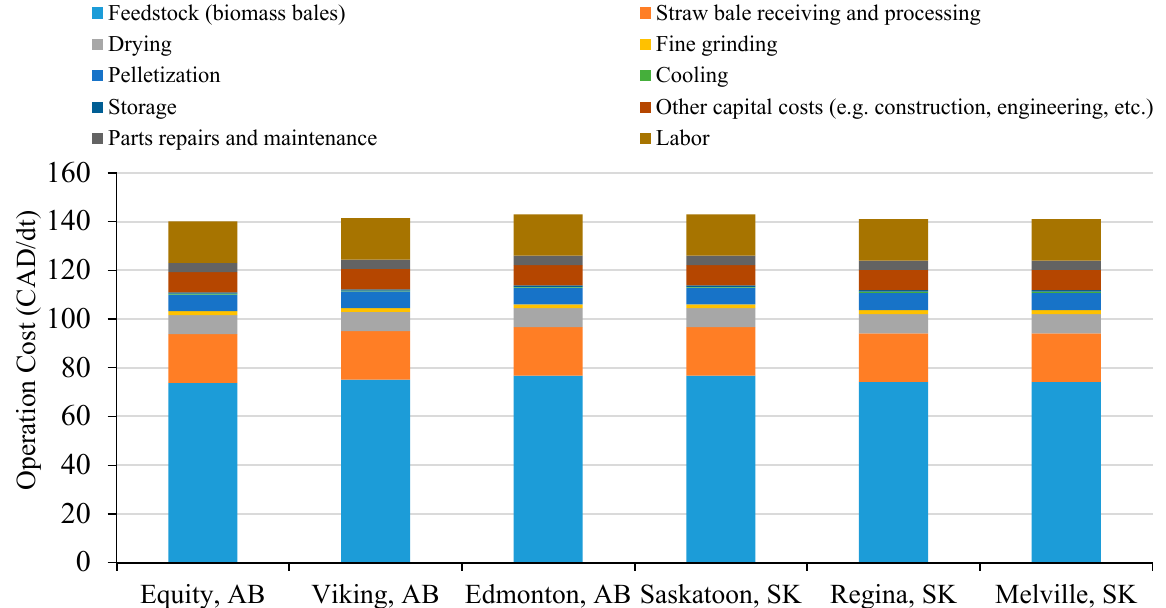
Figure 10. Ag-pellet production cost at the six potential ag-pellet production regions.